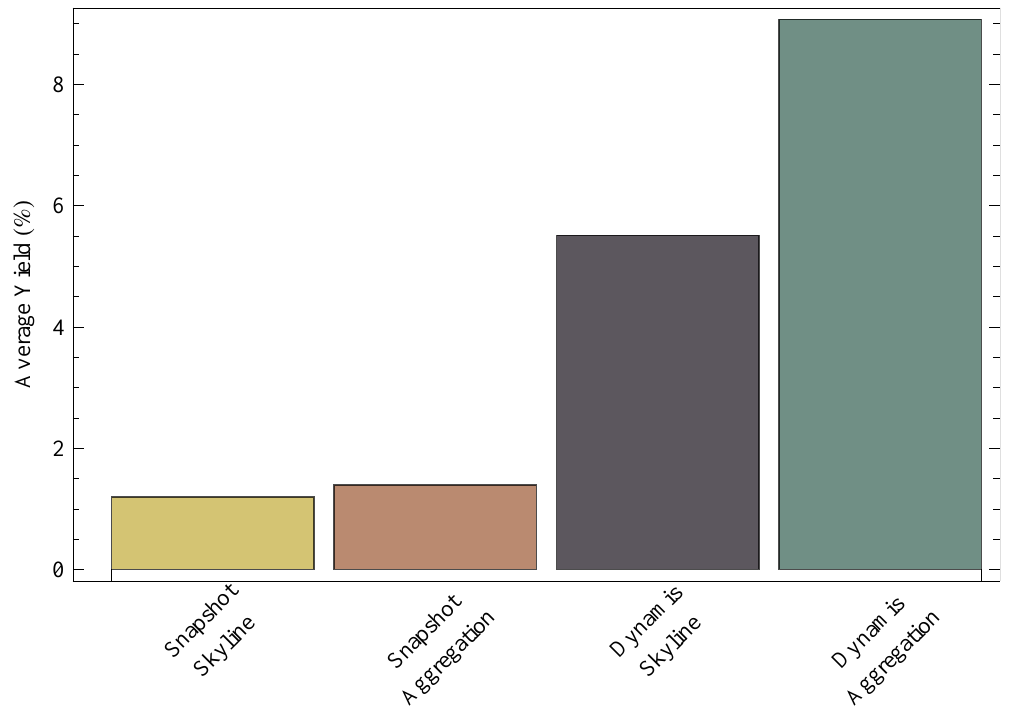
Figure 17. Average yield at the end of the evaluation period for our four algorithms with k = 10 and w =